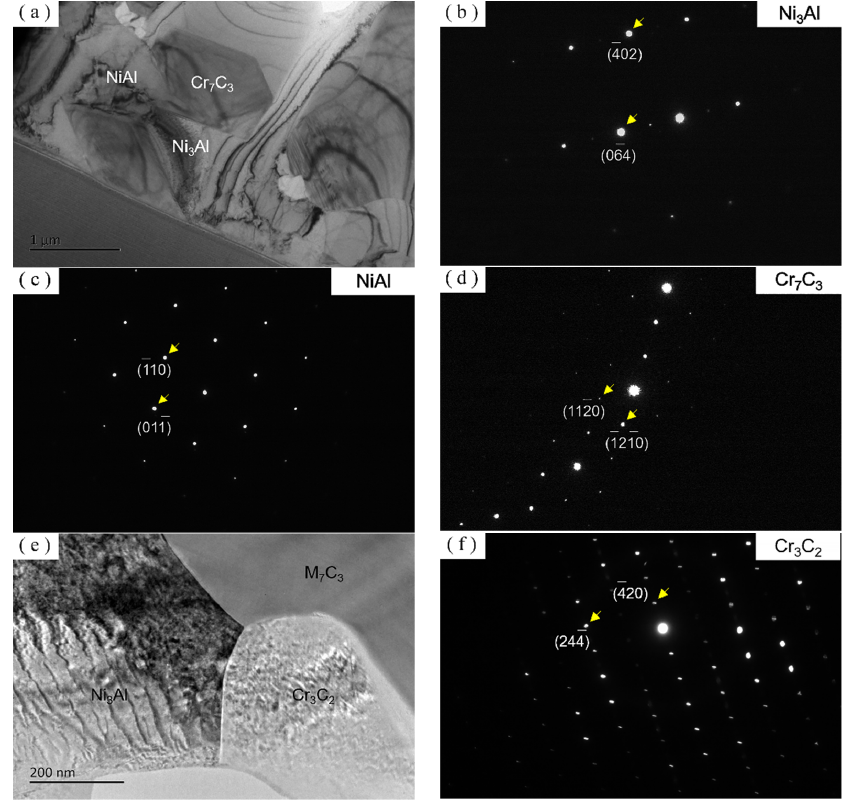
Figure 10. TEM results of the mixed powder cladding layer. ( a , e ) TEM images of Ni 3 Al, NiAl, Cr 7 C 3 , and Cr 3 C 2 ; ( b – d ) electron diffraction patterns of Ni 3 Al, NiAl, and Cr 7 C 3 respectively; ( f ) electron diffraction pattern of Cr 3 C 2